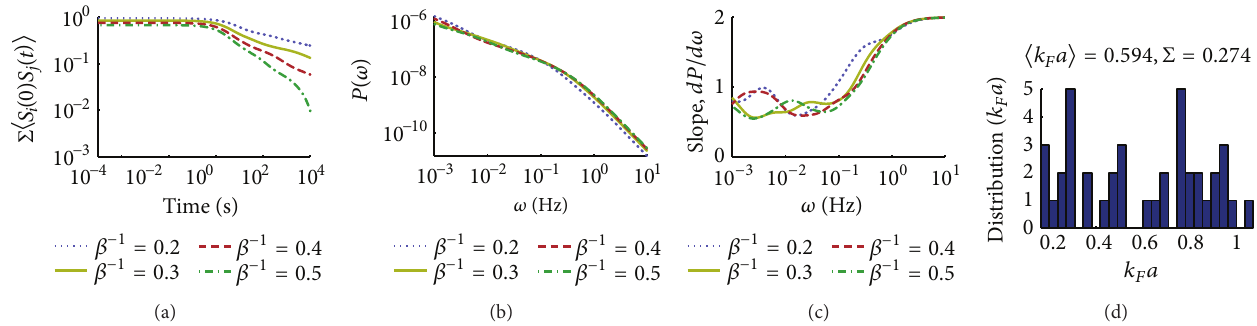
Figure 7: (a) Temperature dependent net correlation function for 20 spin clusters, each with 9 spins with ferromagnetic ( +|𝐽 𝑜 | ) RKKY interactions. Note that the overall results are independent of cluster size. (b) Corresponding flux noise spectrum showing 1/𝑓 𝛼 noise below ∼ 0.1Hz and (c) its respective slope 𝛼 , where 𝛼 ≲ 1 below about 0.1 Hz. (d) Distribution of 𝑘 deviation ( Σ ) as